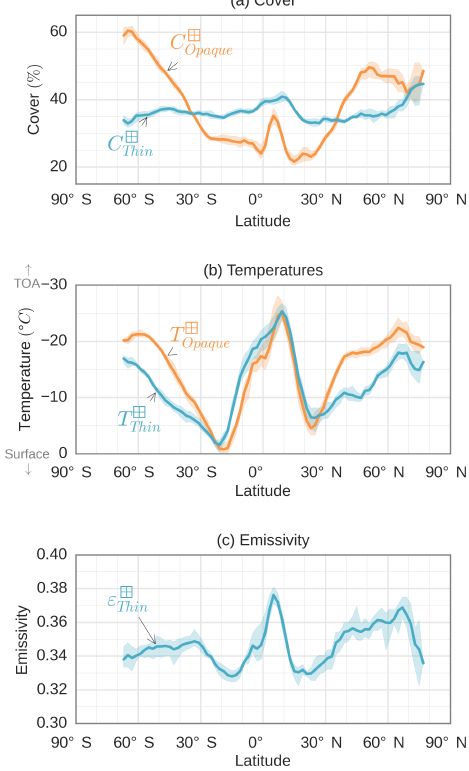
(cid:1) (cid:1) , opaque and C thin (cid:1) among thin clouds and thin